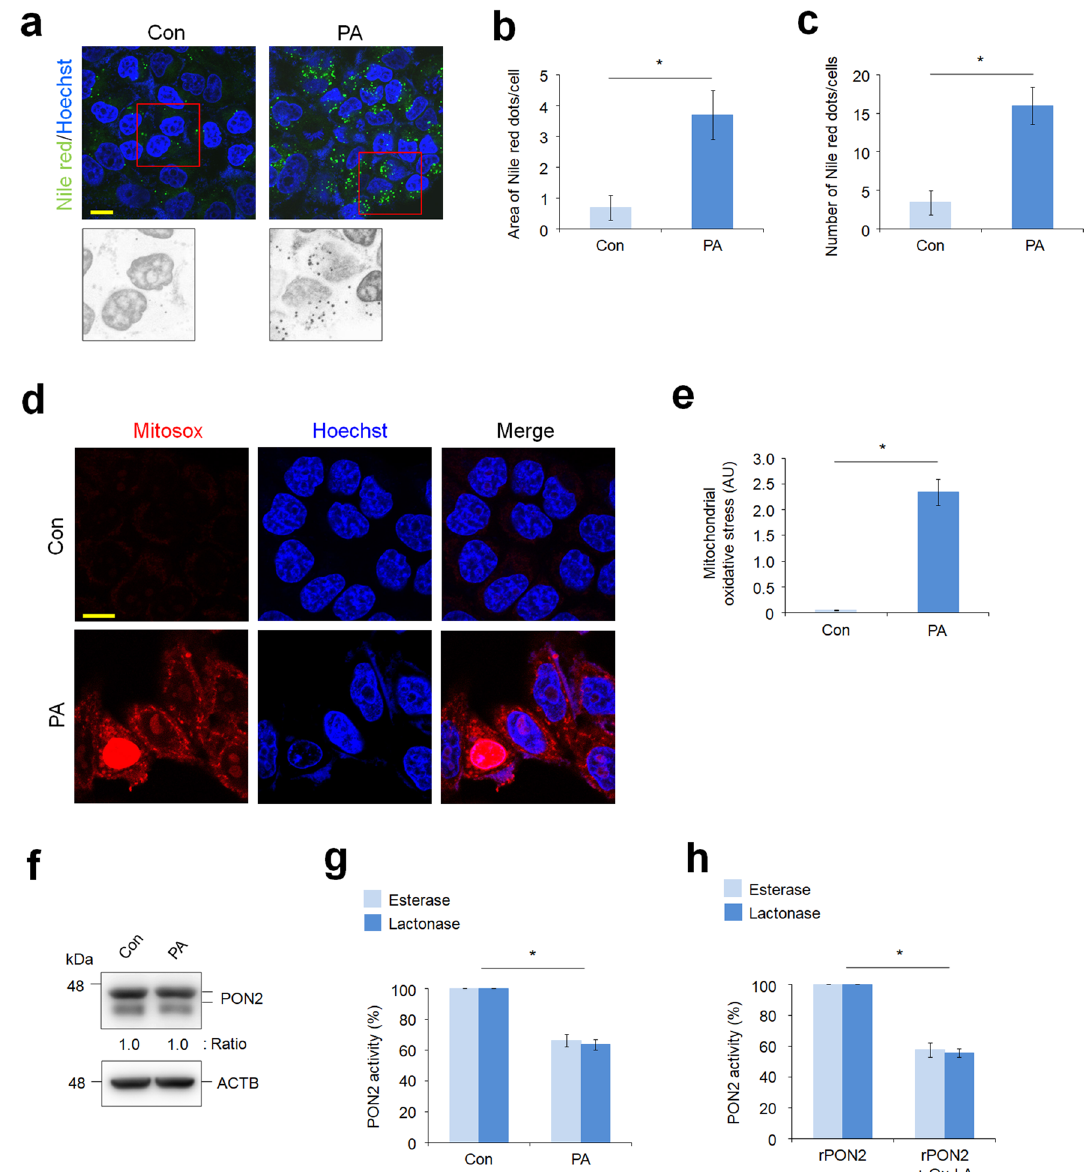
Figure 1. Palmitic acid (PA)-mediated lipotoxic condition inhibits the paraoxonase-2 (PON2) activity in hepatocytes. ( a ) Confocal fluorescence analysis showing PA-induced lipid accumulation. L02 hepatocytes were treated with PA (100 μM) for 24 h and stained with Nile red to determine lipid accumulation. Representative images from three independent experiments are shown (scale bar = 50 μm). ( b , c ) Quantification of Nile red staining intensities is measured by the area of Nile red dots per cells ( b ) and by the number of Nile red dots per cells ( c ). ( d ) Confocal fluorescence images showing the generation of mitochondrial superoxide, which was analyzed using MitoSox staining. L02 cells were treated with PA for 24 h and stained with MitoSox. Cell nuclei were stained with Hoechst 33342. Representative images from three independent experiments are shown (scale bar = 50 μm). ( e ) Bar plots of the quantification of MitoSox staining intensities are shown. ( f ) Immunoblot analysis of PON2 expression in cells treated with or without PA. ACTB was used as a loading control. Band intensities of the indicated proteins are shown below. ( g ) Endogenous PON2 activities in L02 cells treated with or without PA for 24 h. Bar plots of the average esterase and lactonase activities are shown (n = 3). ( h ) Purified recombinant PON2 activities incubated with or without oxidized linoleic acid (Ox-LA) for 10 min. Bar plots of the average esterase and lactonase activities of recombinant PON2 (n = 3). Error bars indicate standard deviation. Statistical significance between two groups was determined with two-tailed Student’s t test. * p <